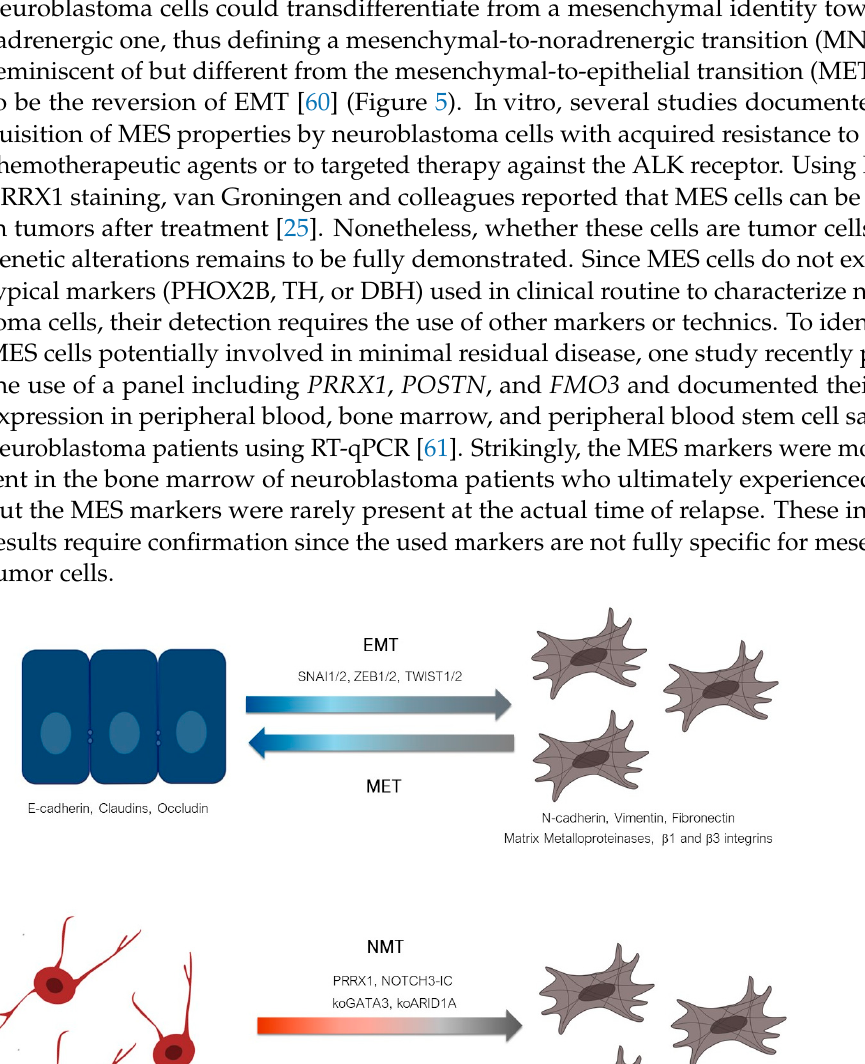
mechanism is thus called